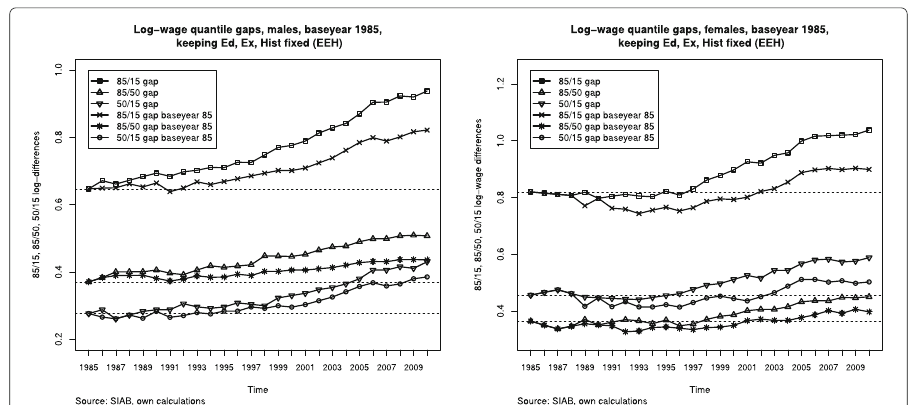
Fig. 12 Inequality development base year 1985, specification EEH (education, experience, labor market